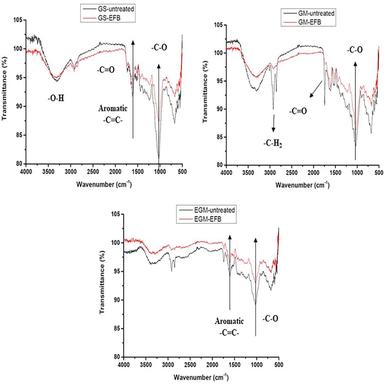
FT-IR analysis for the winemaking waste grape stalks (GS), grape marc (GM) and exhausted grape marc (EGM): untreated and extractives-free biomass (EFB) derived.